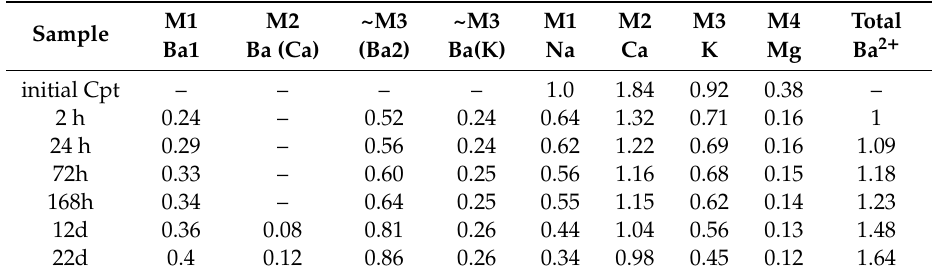
Table 8. Number of atoms per unit cell in the cationic positions of initial and Ba-exchanged clinoptilolite (Cpt) at RT (after structural refinement).